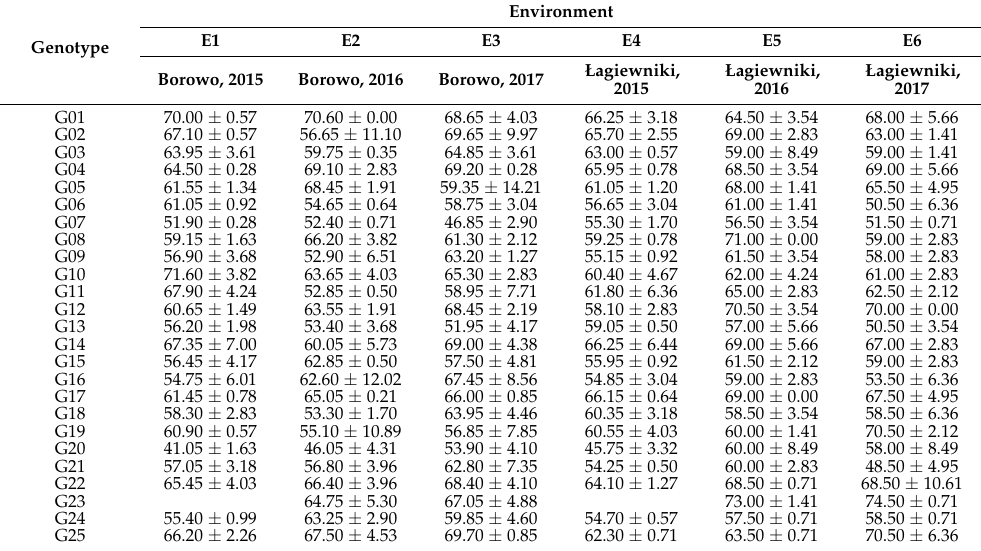
Table 10. Mean values ± standard deviations (s.d.) for length of silique of winter oilseed rape genotypes in particular environments.